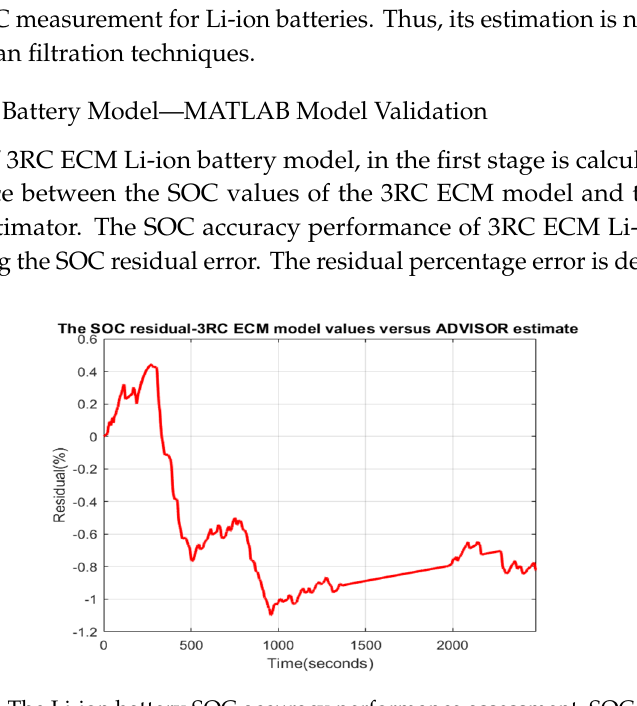
Figure 15. The Li-ion battery SOC accuracy performance assessment–SOC residual.